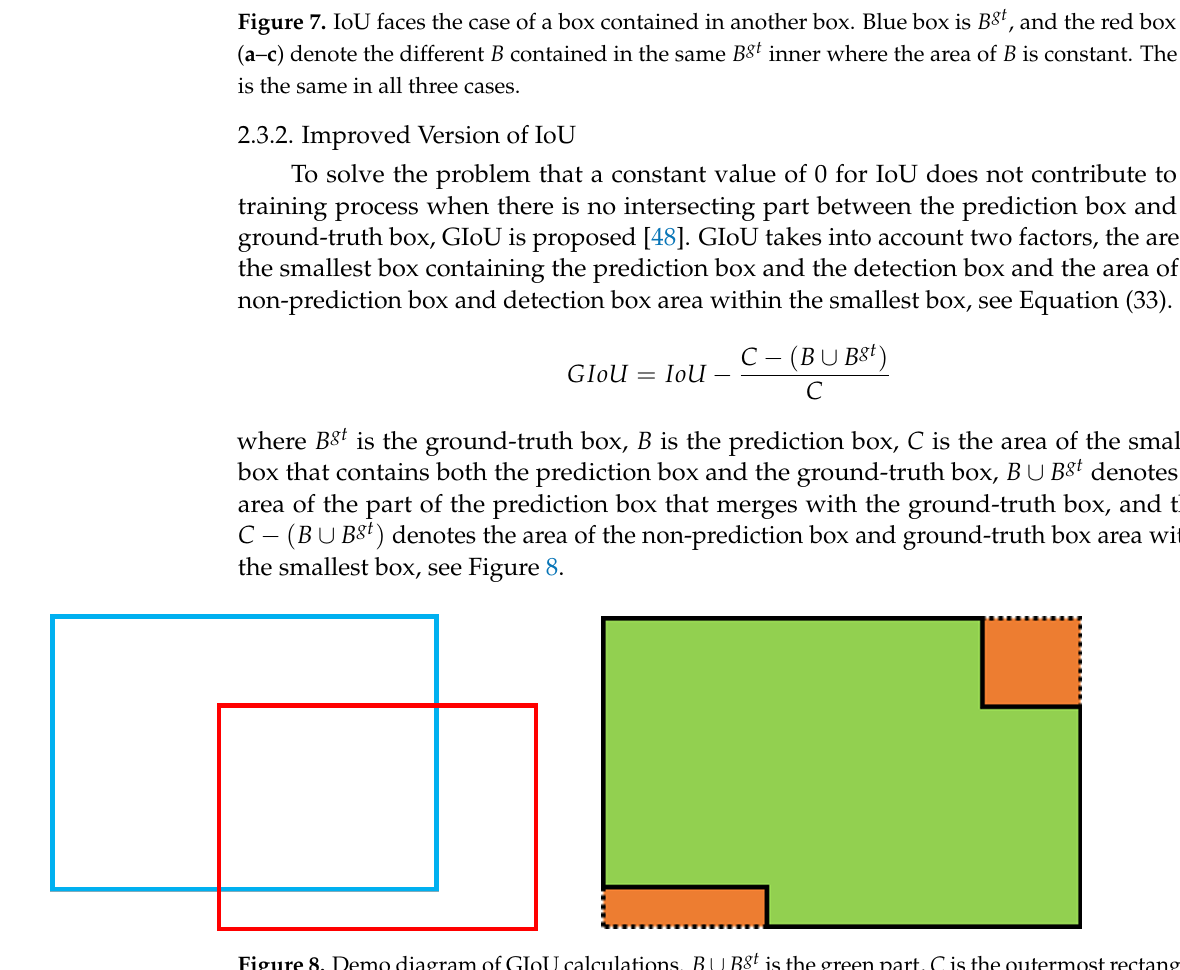
Figure 8. Demo diagram of GIoU calculations. B ∪ B gt is the green part, C is the outermost rectangular part, and C − ( B ∪ B gt ) is the orange